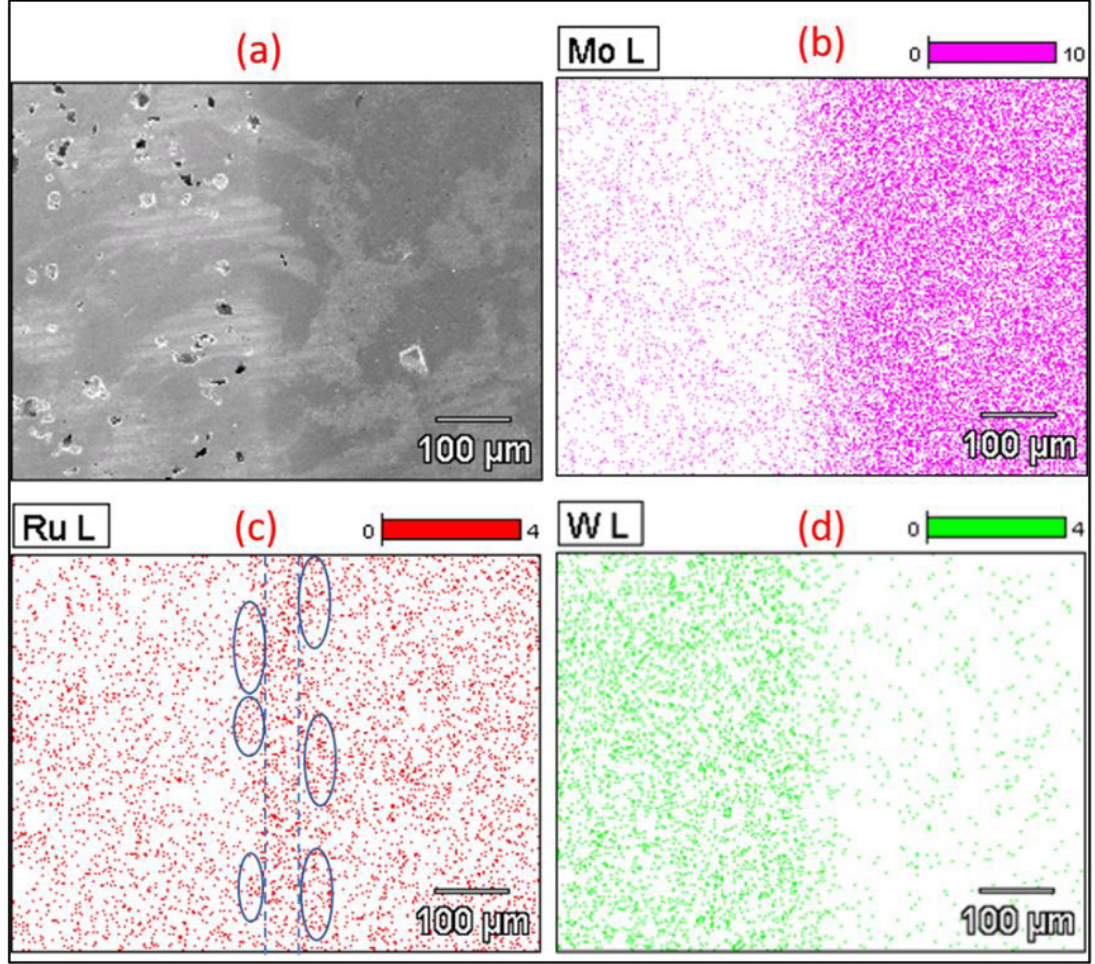
Figure 13. (a) SEM with a 150x magnification in the junction area, (b) EDS map counting Mo in the junction area, (c) EDS map counting Ru in the junction, and (d) EDS map counting W in the same region.